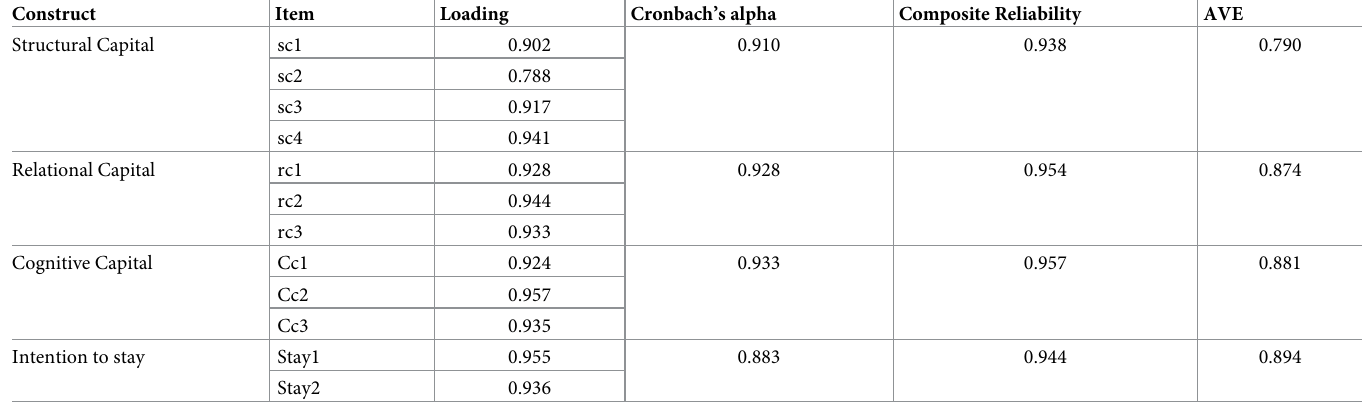
Table 3. Measurement model